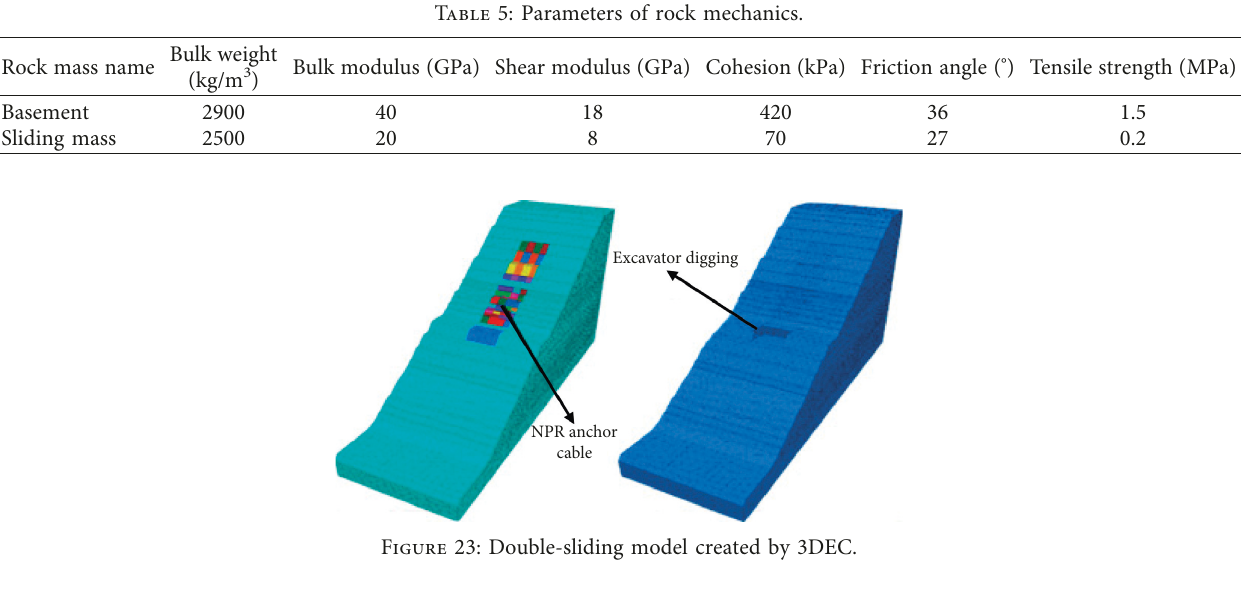
Table 5: Parameters of rock mechanics.